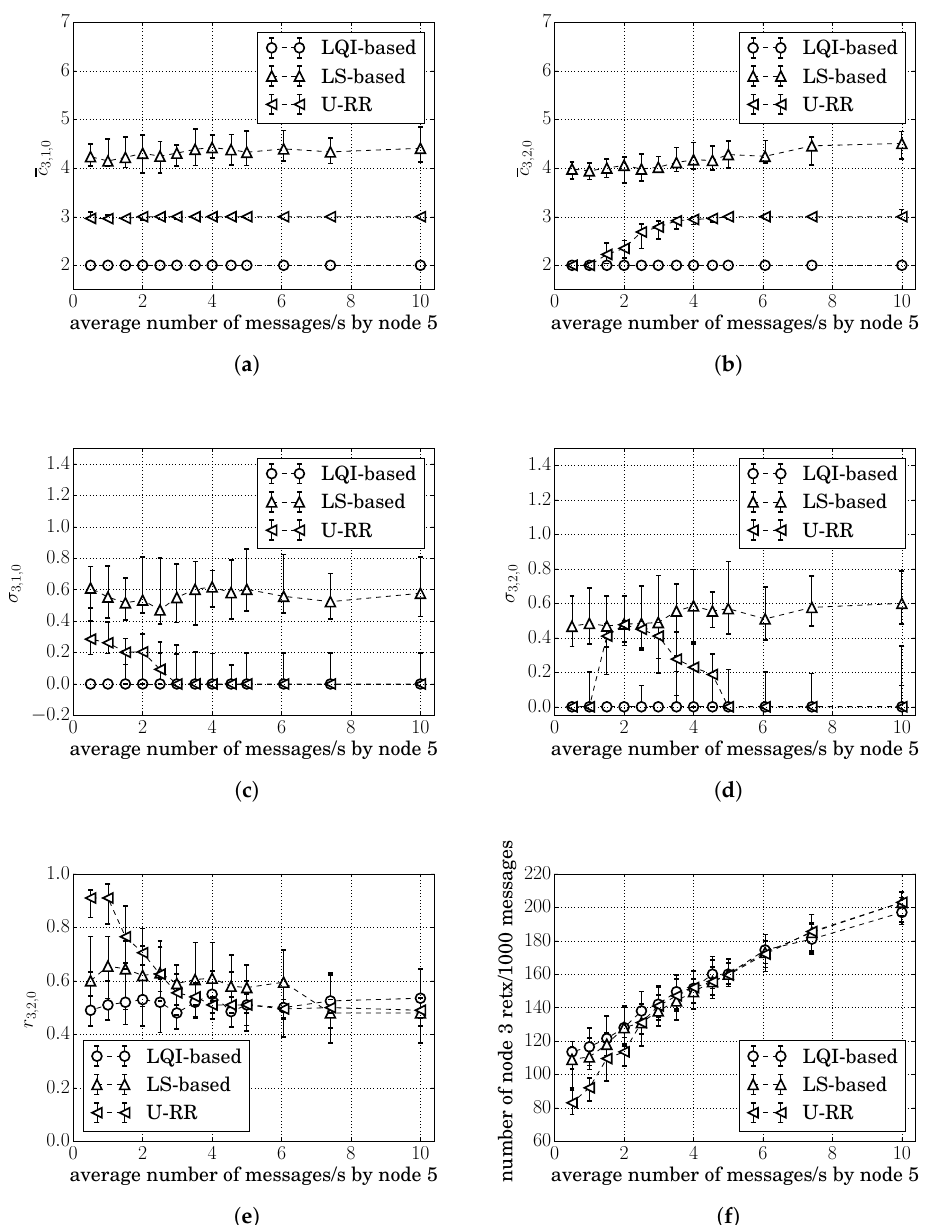
Figure 9. The median and the 15th to 85th percentiles of ( a ): the cumulative route costs of the route 3,1,0 ( c 3,1,0 ), ( b ): the cumulative route costs of the route 3,2,0 ( c 3,2,0 ), ( c ): the standard deviation of the estimated costs measured at node 3 for the route 3,1,0 ( σ 3,1,0 ), ( d ): the standard deviation of the estimated costs measured at node 3 for the route 3,2,0 ( σ 3,2,0 ), ( e ): the ratio of times that route 3,2,0 was chosen ( r 3,2,0 ), and ( f ): the number of times that node 3 had to retransmit per 1000 messages generated in the scenario